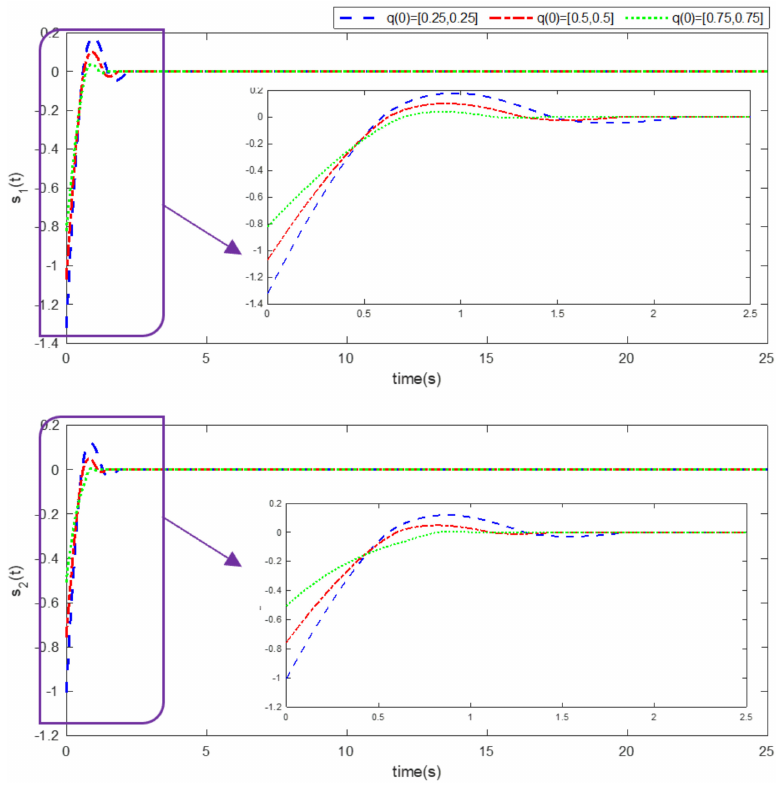
Figure 11. Time history of the sliding surface under different initial conditions. (Example 2).